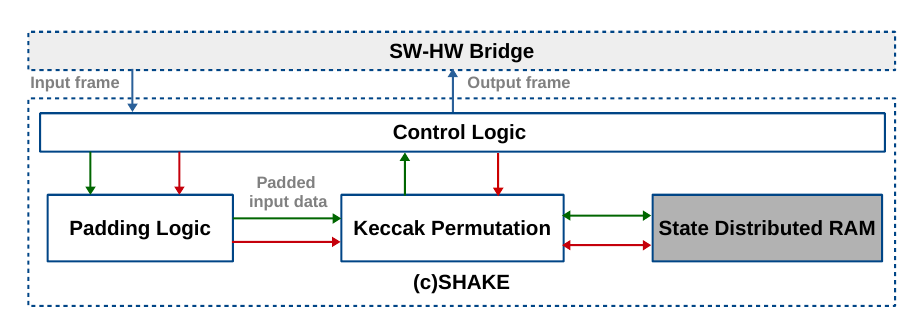
Figure 1: Dataflow diagram of the SHAKE hardware module. Red arrows represent control signals, green arrows represent data signals, and blue arrows represent the external